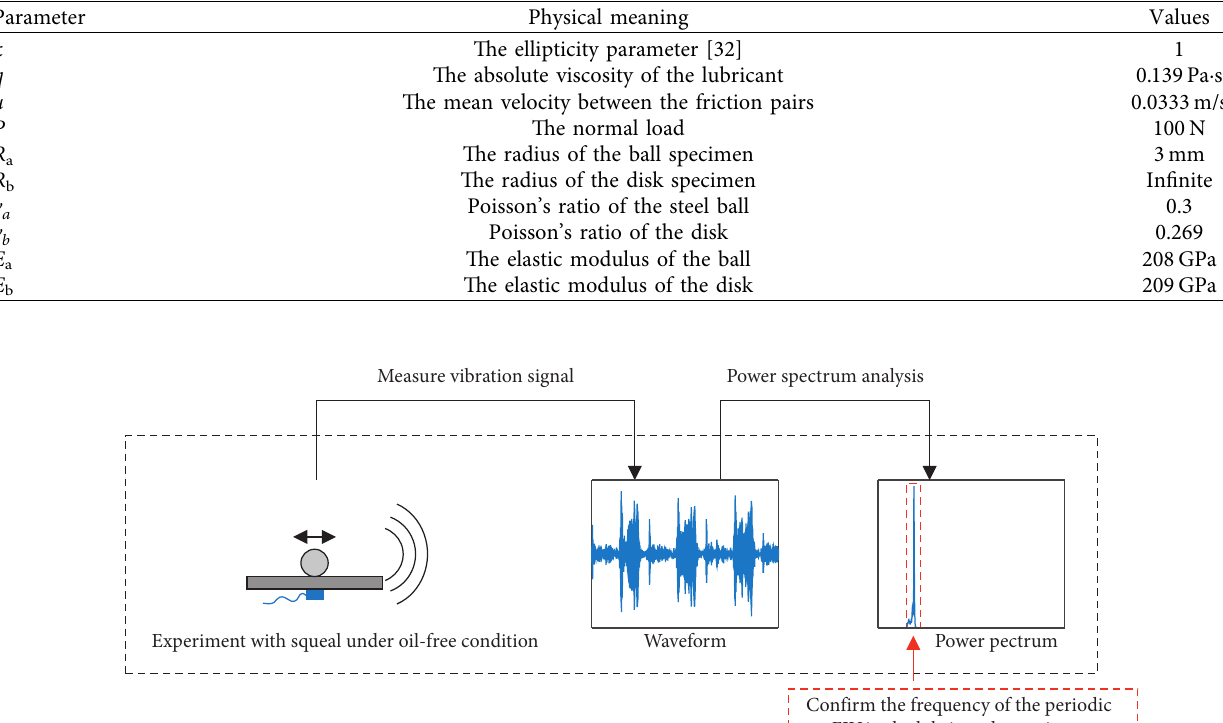
Table 1: The parameter